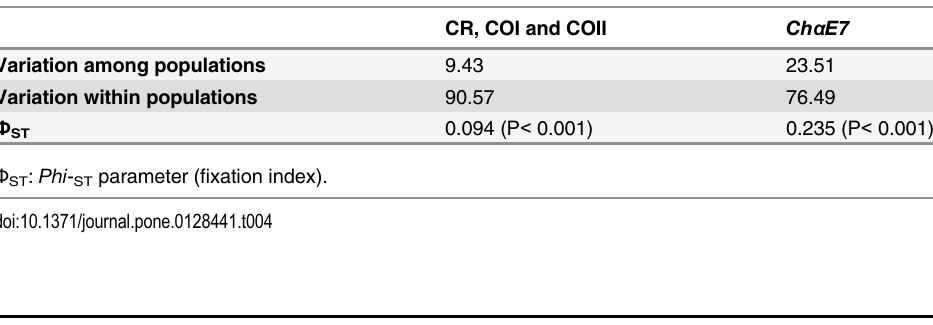
Table 4. AMOVA results for mitochondrial (CR, COI and COII) and Ch α E7 genes.